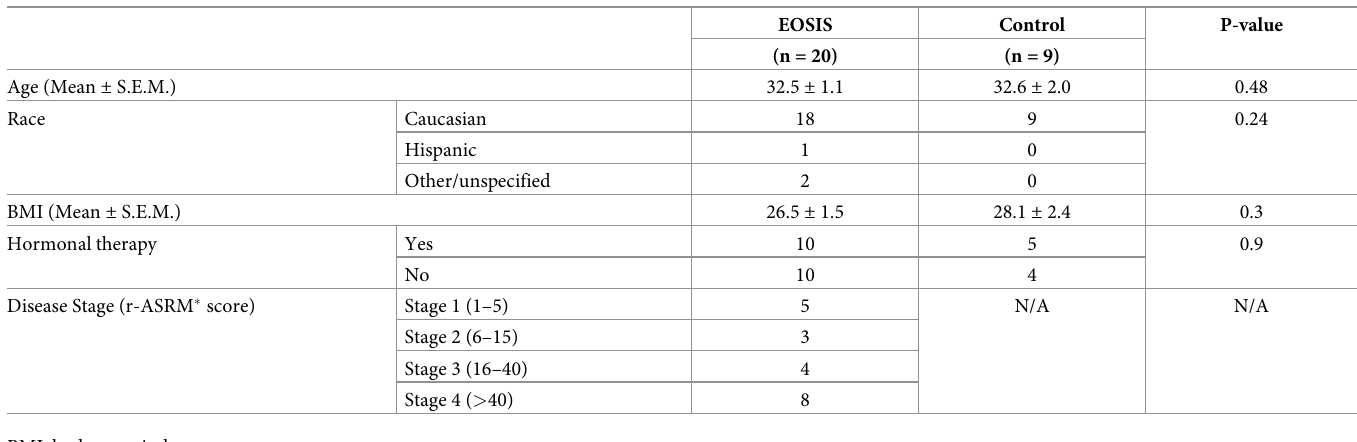
Table 1. Demographic of study